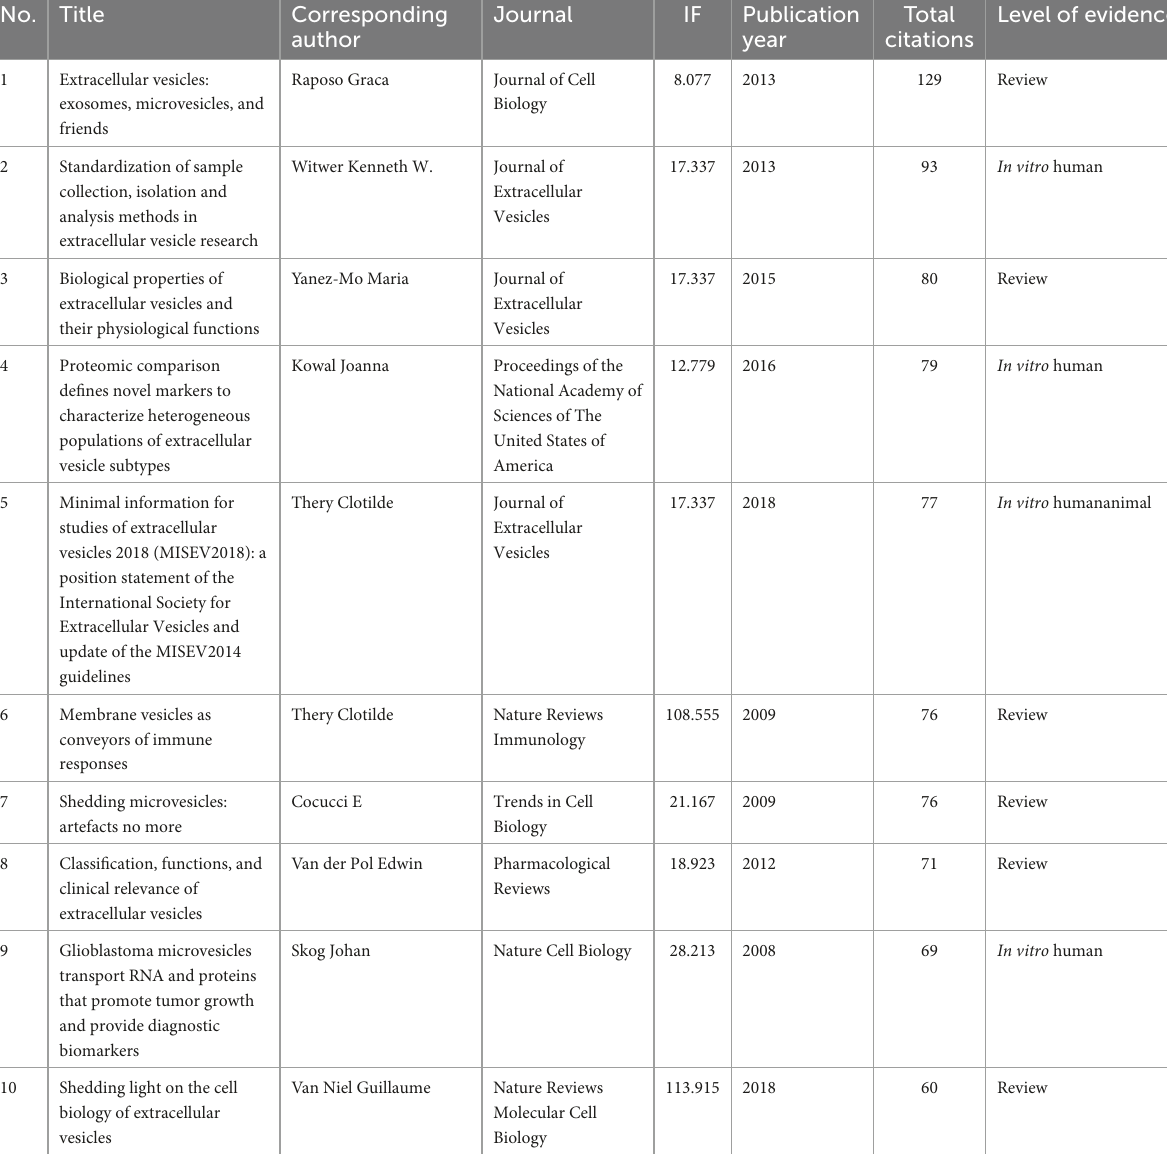
TABLE 6 The top 10 references in the field of exosome that have received the most